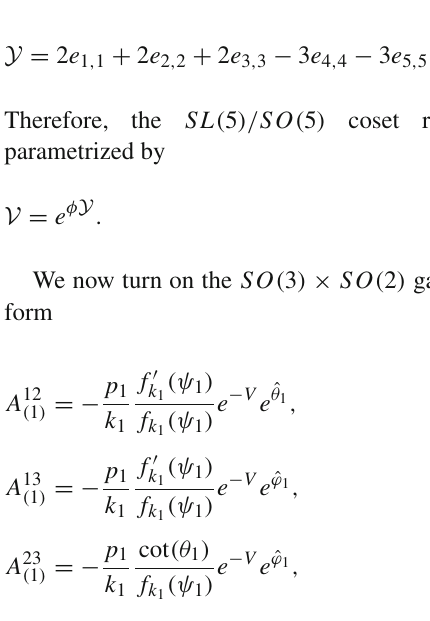
, − 1 , − 1 , − 1 , respectively 25 31 40 46